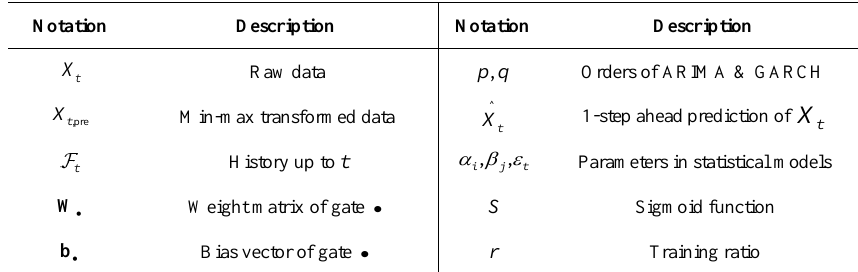
Table 1. Summary of